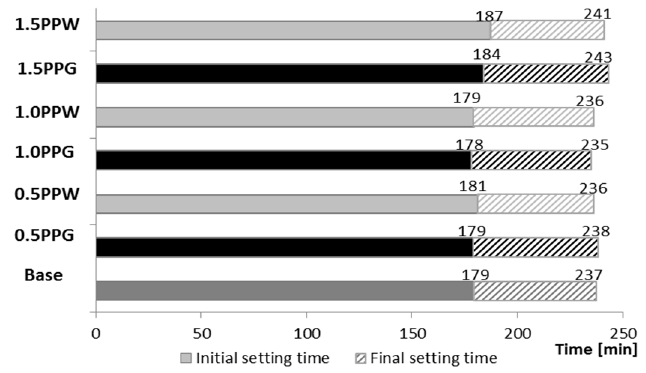
Figure 5. Distribution of initial and final setting times of tested mixes: PPG marked in black, PPW marked in light grey, base mix (no fibers) marked in dark grey.